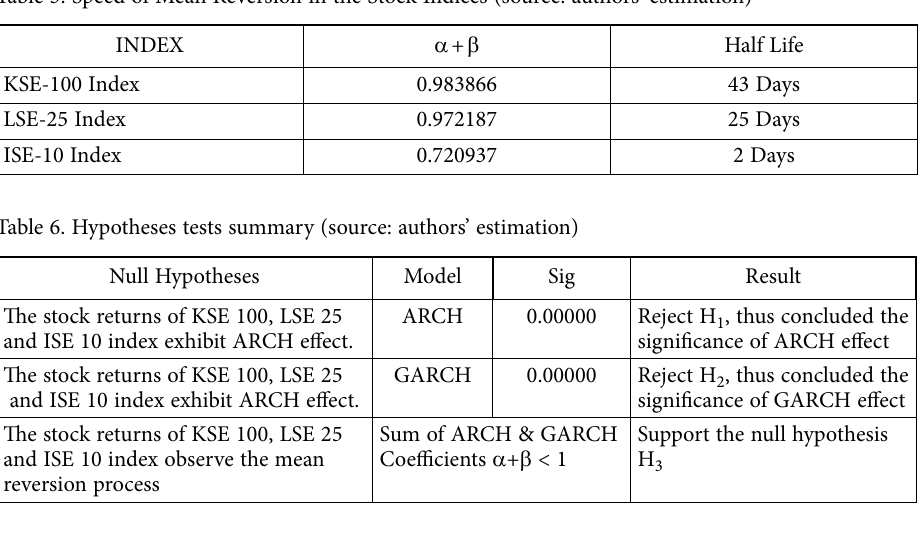
Table 5. Speed of Mean Reversion in the Stock Indices (source: authors’ estimation)